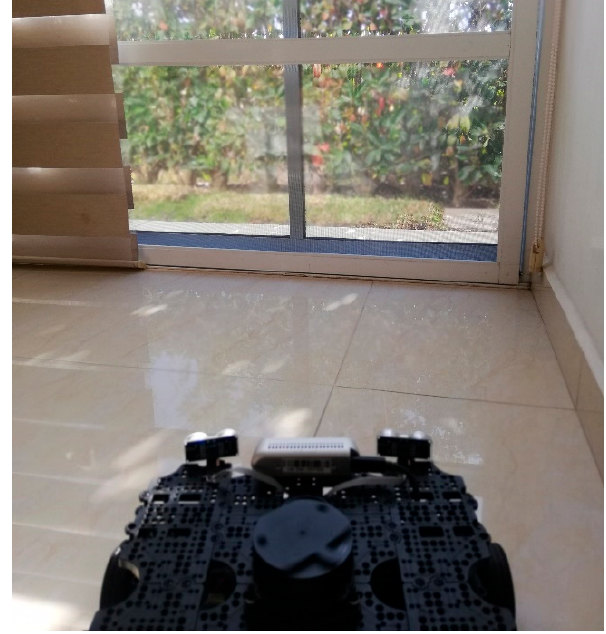
Figure 25. Point of interest of scenario 3.